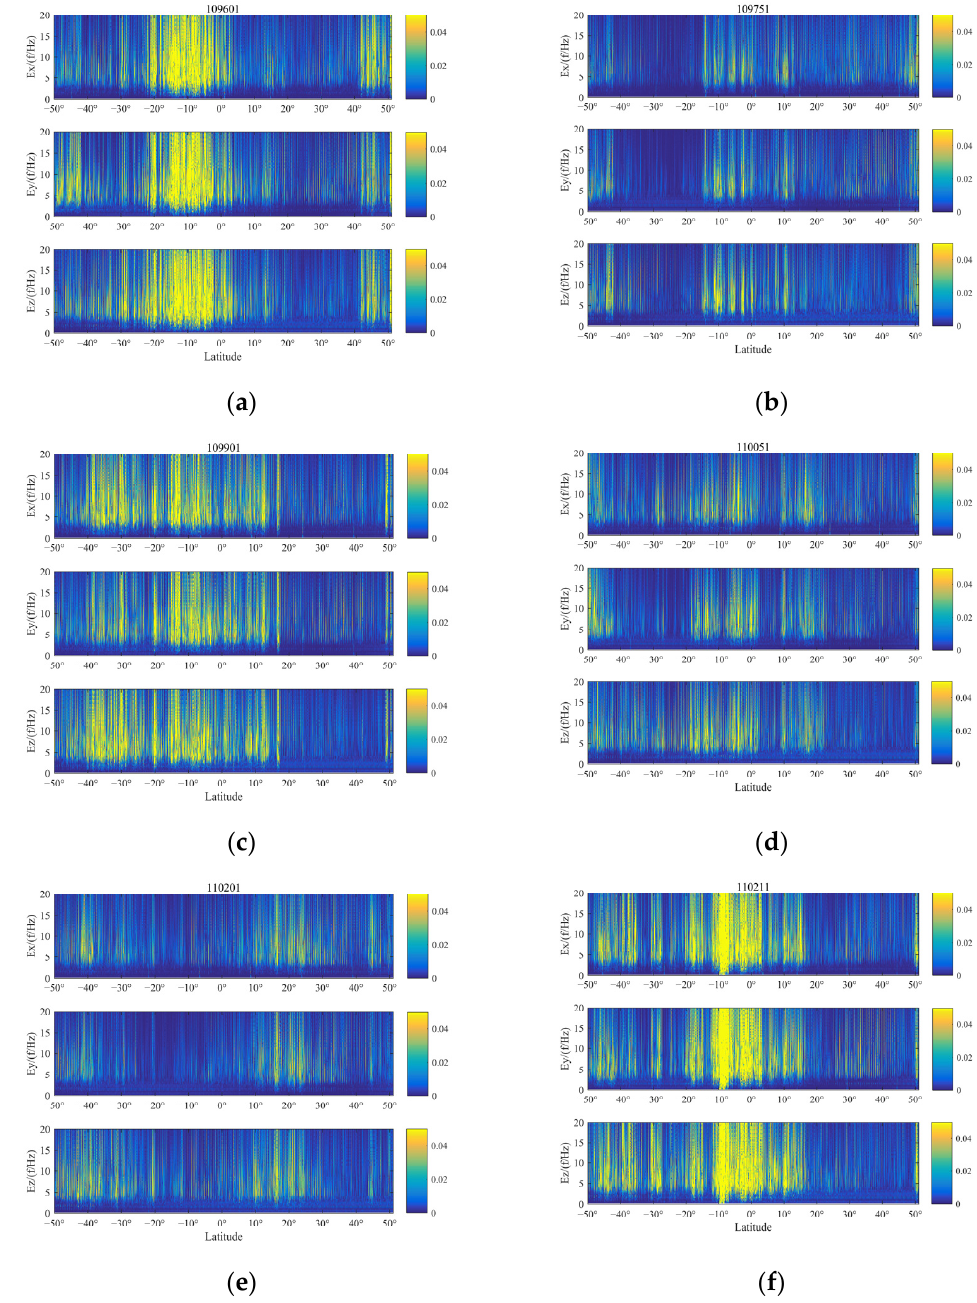
Figure 4. Three-component wavelet time-frequency analysis diagram of electric field before earthquake. ( a ) Orbit of 109,601; ( b ) orbit of 109,751; ( c ) orbit of 109,901; ( d ) orbit of 110,051; ( e ) orbit of 110,201; ( f ) orbit of 110,211.